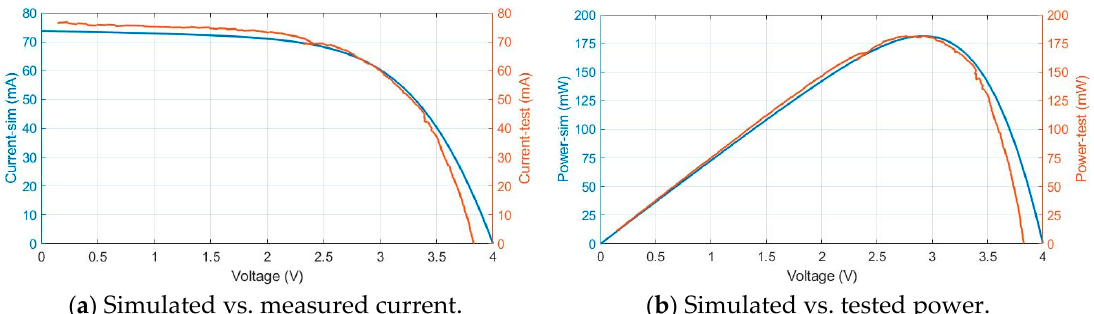
46 ◦ C temperature. °C temperature.